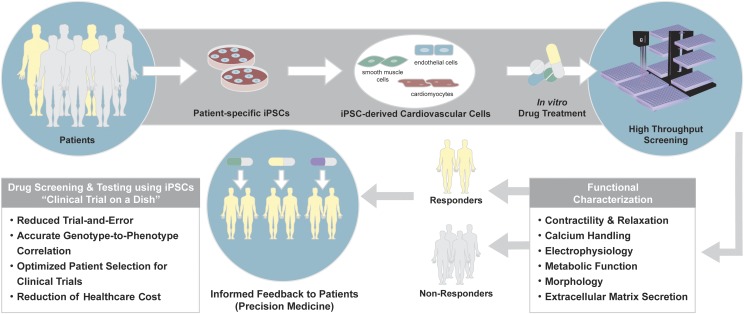
Drug screening and testing using patient-specific iPSCs. Patient-specific iPSCs provide a platform for personalized drug screening and testing. iPSCs generated from individual patients are differentiated into cardiovascular cells of interest and subjected to drug treatment in vitro. High-throughput methods allow functional characterization of the cells during or after drug treatment, from which responders vs. nonresponders and the side effects of the drug are identified. This information allows informed feedback to the patients regarding the drug’s efficacy and toxicity based on the individual responses to the drug. As such, patient-specific iPSC-based drug screening and testing provide accurate genotype-to-phenotype correlation that results in precise drug discovery and reduces the stressful and costly trial-and-error process for the patients, not to mention significantly reducing the cost of health care.